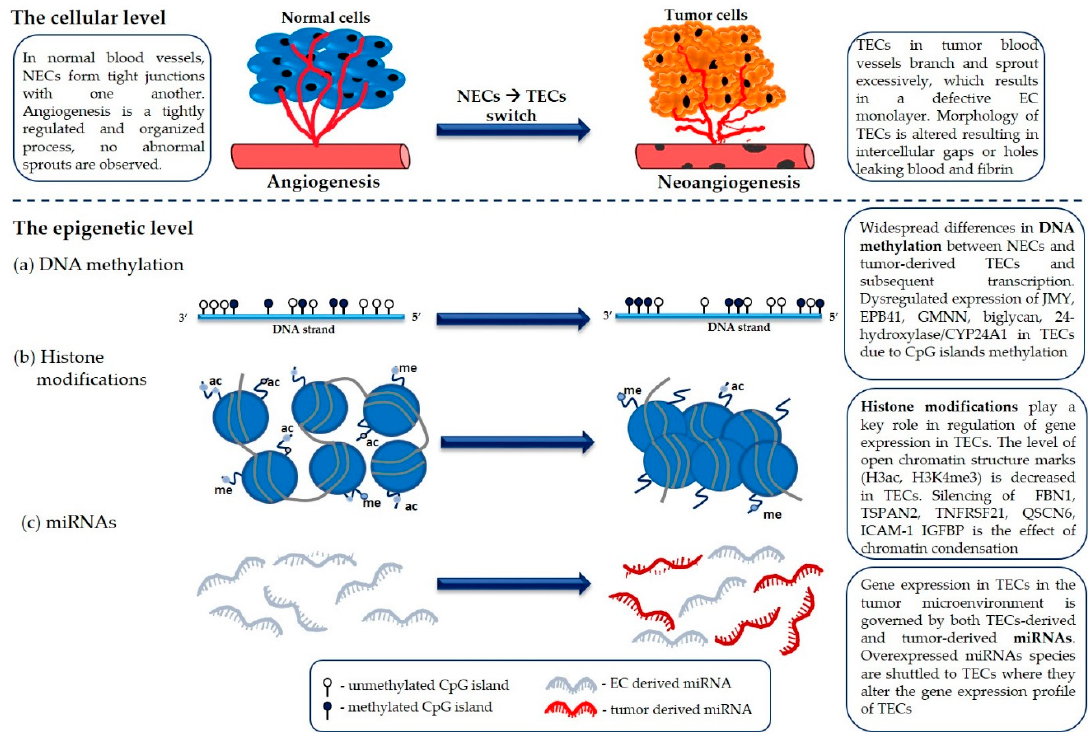
Figure 3. Summary of epigenetic mechanisms including ( a ) DNA methylation, ( b ) histone Figure 3. Summaryofepigeneticmechanismsincluding( a )DNAmethylation, ( b )histoneposttranslational posttranslational modifications, and ( c ) microRNA, involved in capillary network formation by modifications, and ( c ) microRNA, involved in capillary network formation by normal and tumor normal and tumor endothelial cells. endothelial